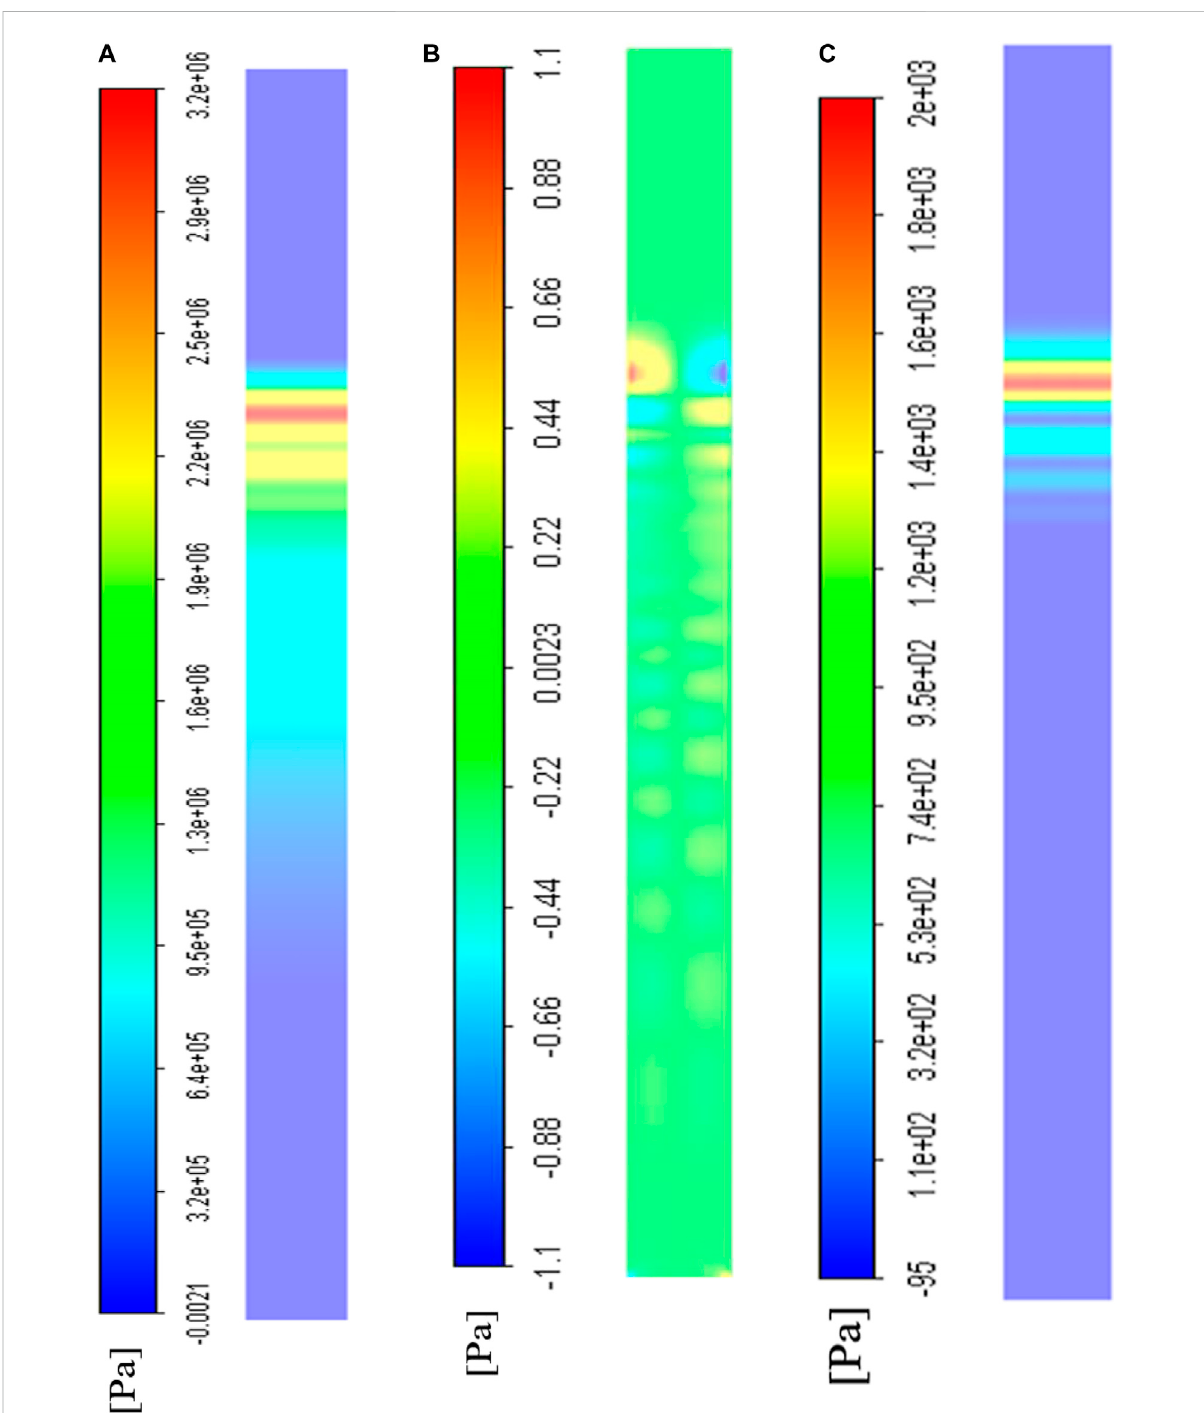
FIGURE 6 TheCFDvisualizationofstressdistributiononthebottomwallwherecellswereculturedat t (cid:2) 0 . 75 T timestep. (A) Thetotalcompressionstress distribution; (B) The transverse shear stress distribution; (C) The axial shear stress